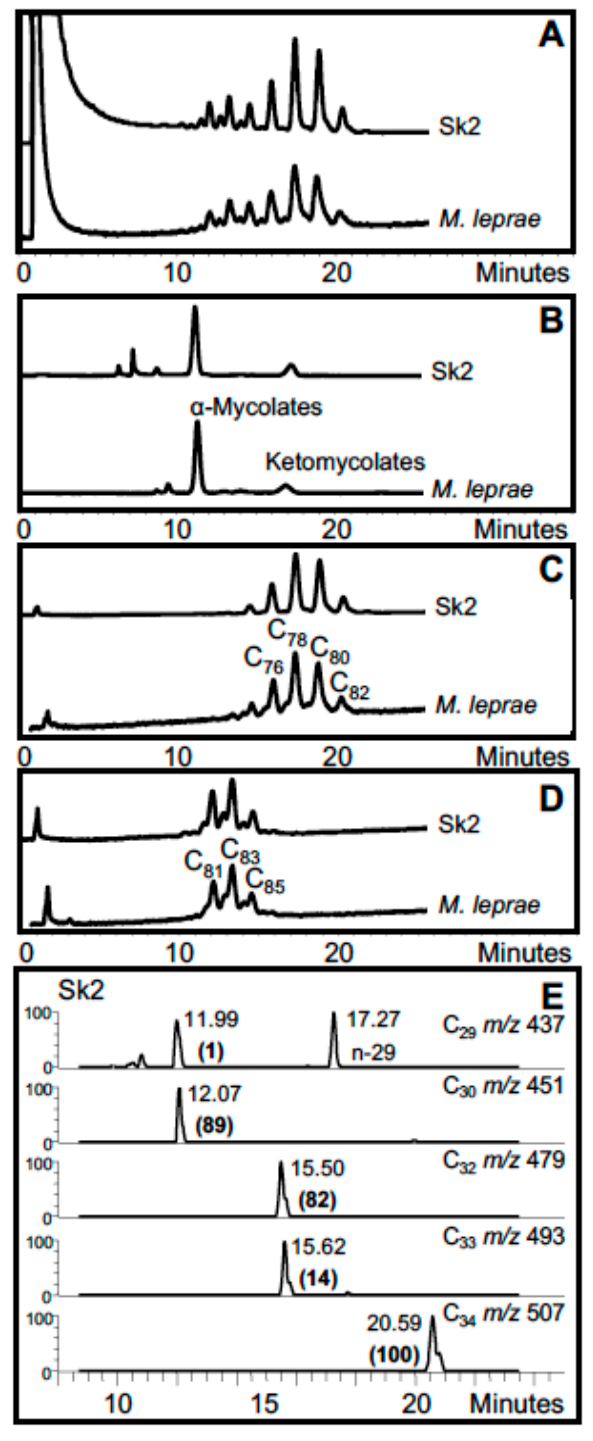
Figure 6. Lipid biomarker profiles for Winchester leprosy specimen Sk2 [38]. ( A ) Total mycolates, reverse phase HPLC; ( B ) Collected total mycolates (MAs), normal phase; ( C ) Collected α -mycolates, reverse phase; ( D ) Collected ketomycolates, reverse phase; ( E ) GC-MS of mycocerosates (C 29 , C 30 , C 32 , C 33 , C 34 ) characteristic of leprosy. Comments: Excellent leprosy MA and mycocerosate profiles. Verdict: Certain leprosy.